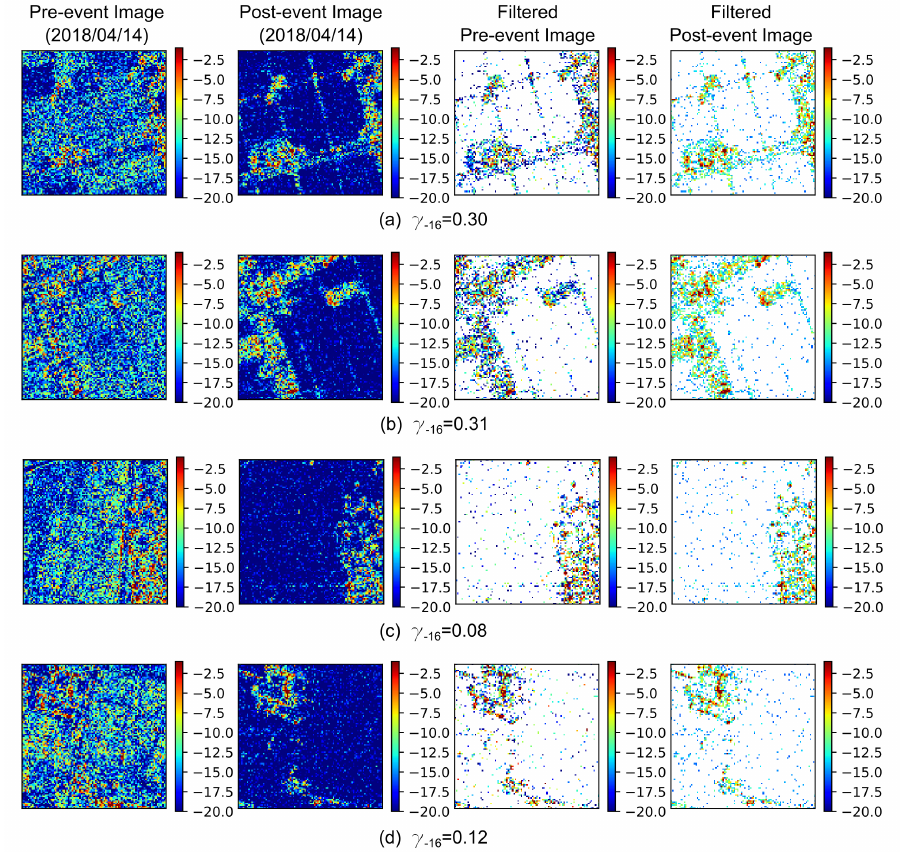
Figure 8. Examples of conditional coherence computed with T = − 16 ( γ − 16 ). The two leftmost columns depict the pre-event and post-event SAR backscattering intensity. The two rightmost columns show only the pixels whose location belongs to the subset A − 16 . ( a,b ) Examples of non-flooded agriculture targets. ( c,d ) Examples of flooded agriculture